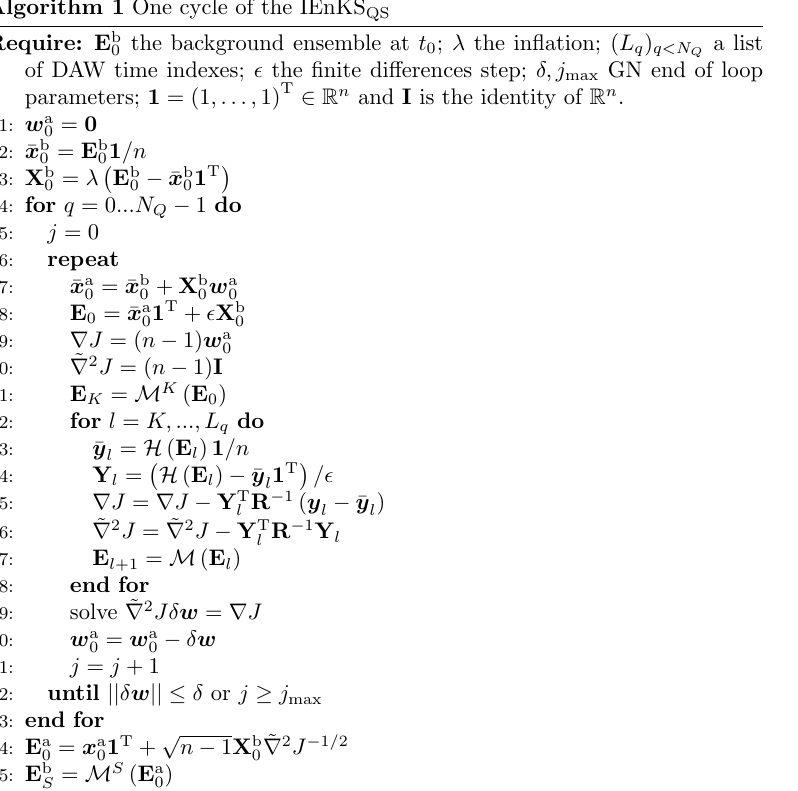
Algorithm 1 One cycle of the IEnKS